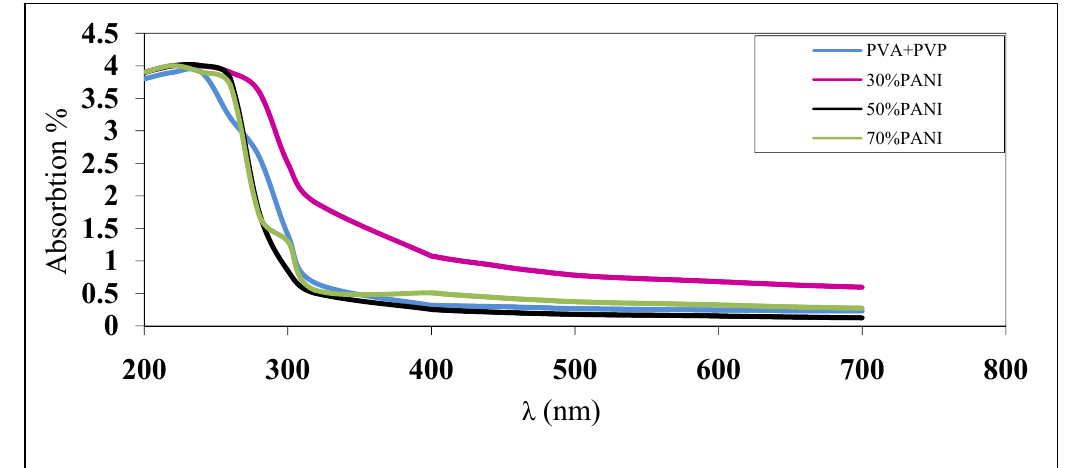
Fig. 3: The absorbance vs. wave length for (PVA-PVP) pure and additive PNAI blends polymer.